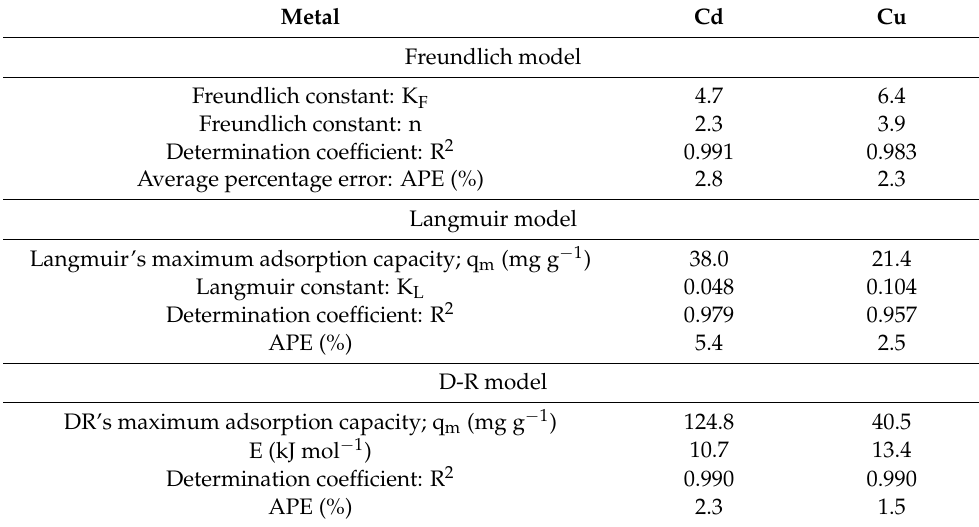
Table 2. Adsorption isotherm parameters of Cd and Cu removal by lignite (D = 2 g L − 1 ; t = 60 min; pH = 5; T = 20 ± 2 ◦